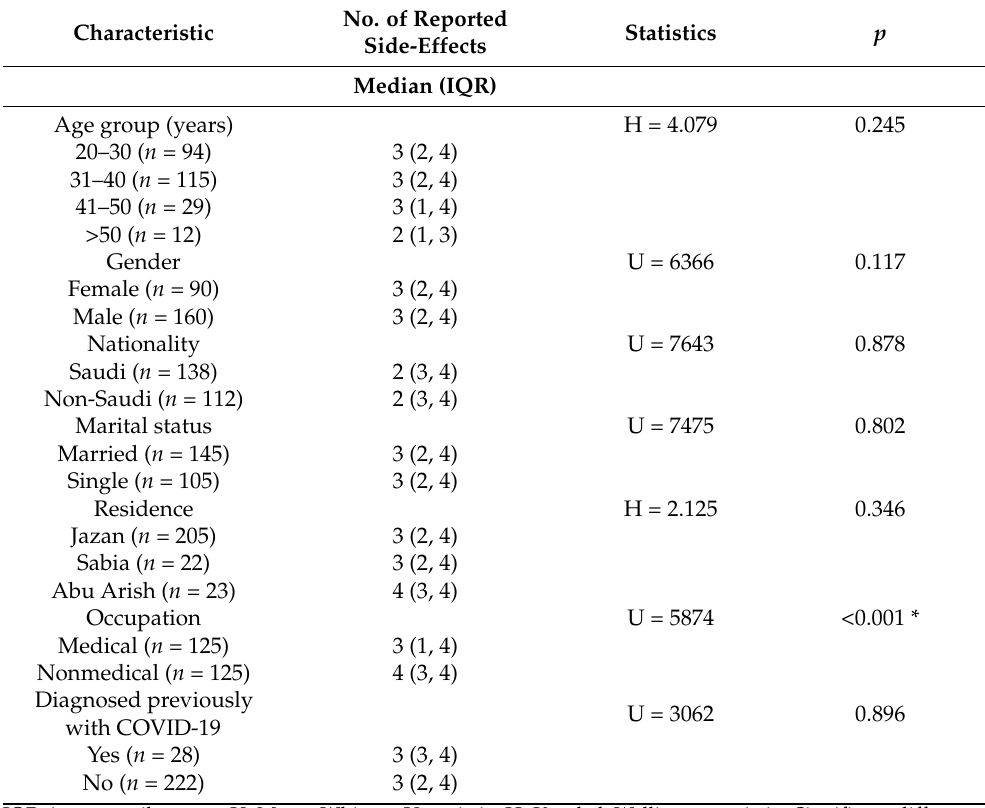
Table 4. Number of side-effects reported by the participants following the first dose of COVID-19 vaccine according to the participants’ background characteristics ( n = 250).